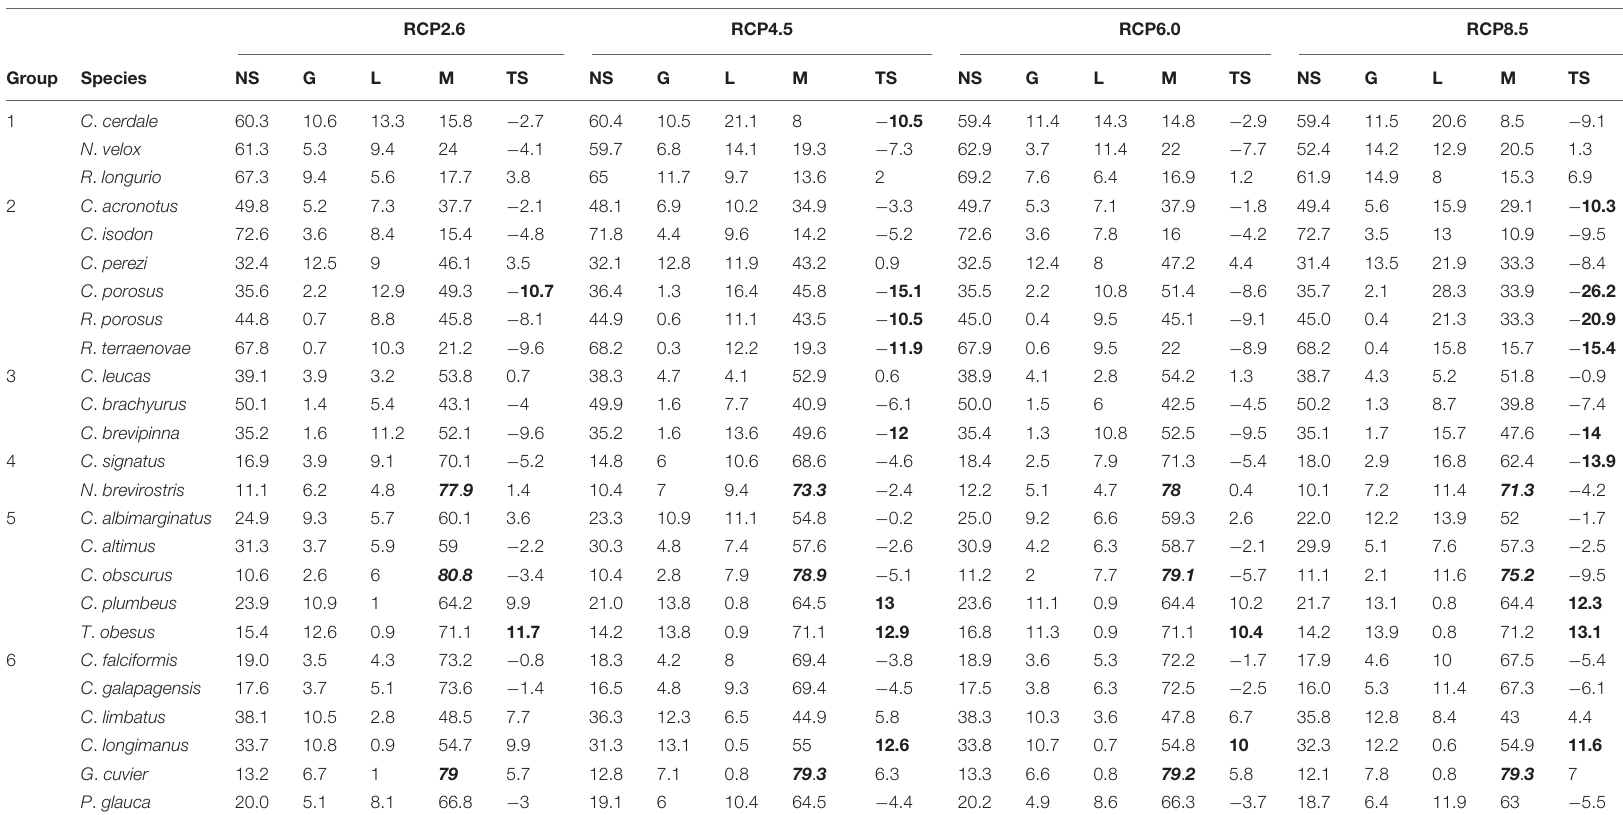
TABLE 3 | Percentage of not suitable (NS), gained (G), lost (L), and maintained (M) areas, and total shift (TS) in the potential geographic distribution of each species under the RCP future scenarios, divided into groups according to their M area. RCP2.6 RCP4.5 RCP6.0